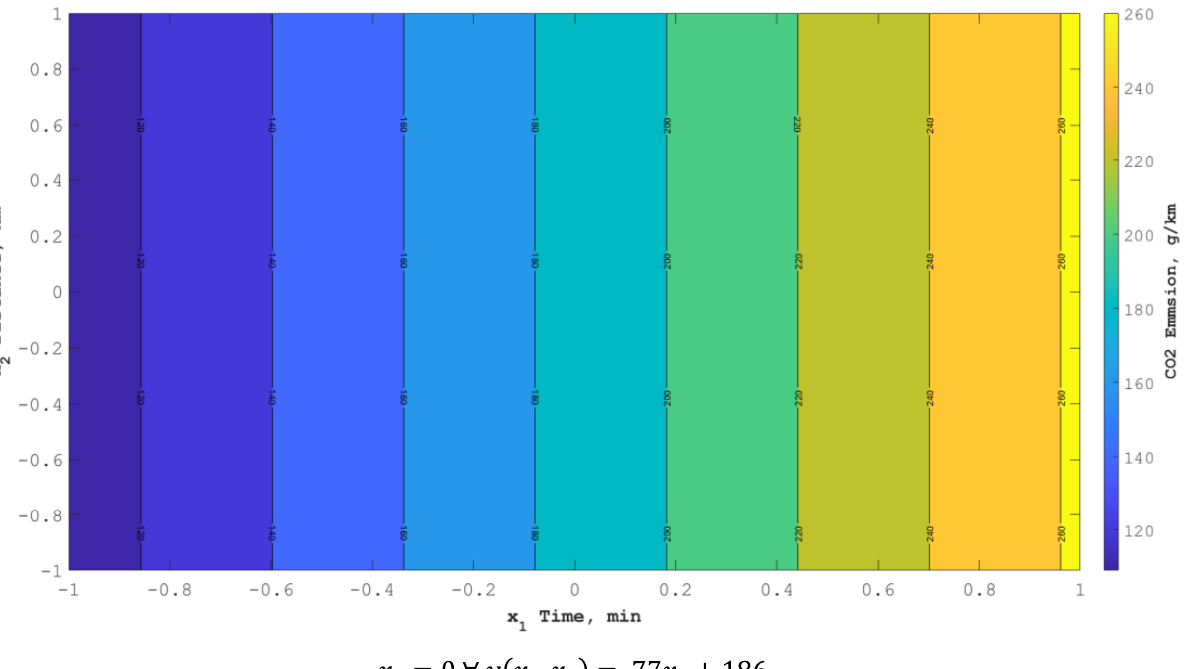
Figure 19. Change in CO 2 emissions depending on the variability of factors x 1 and x 2 for a vehicle (EV) moving at a temperature of 25 °C (x 3 = 1). Analyzing the obtained results presented in Figures 11 – 19, it can be concluded that for an electric vehicle, the factors describing the time of the distance covered (x 1 = −1 ∨ x 1 = 0 ∨ x 1 = 1) and the length of the route covered (x 2 = −1 ∨ x 2 =0 ∨ x 2 = 1) were characterized by a nonlinear relationship. An important fact is the existence of constant CO 2 emission values for some conditions. As in the case of the vehicle with an ICE, the vehicle with an EE also showed a linear relationship for the influence of outside temperature (x 3 ) on CO 2 emissions, but it achieved lower emission values.